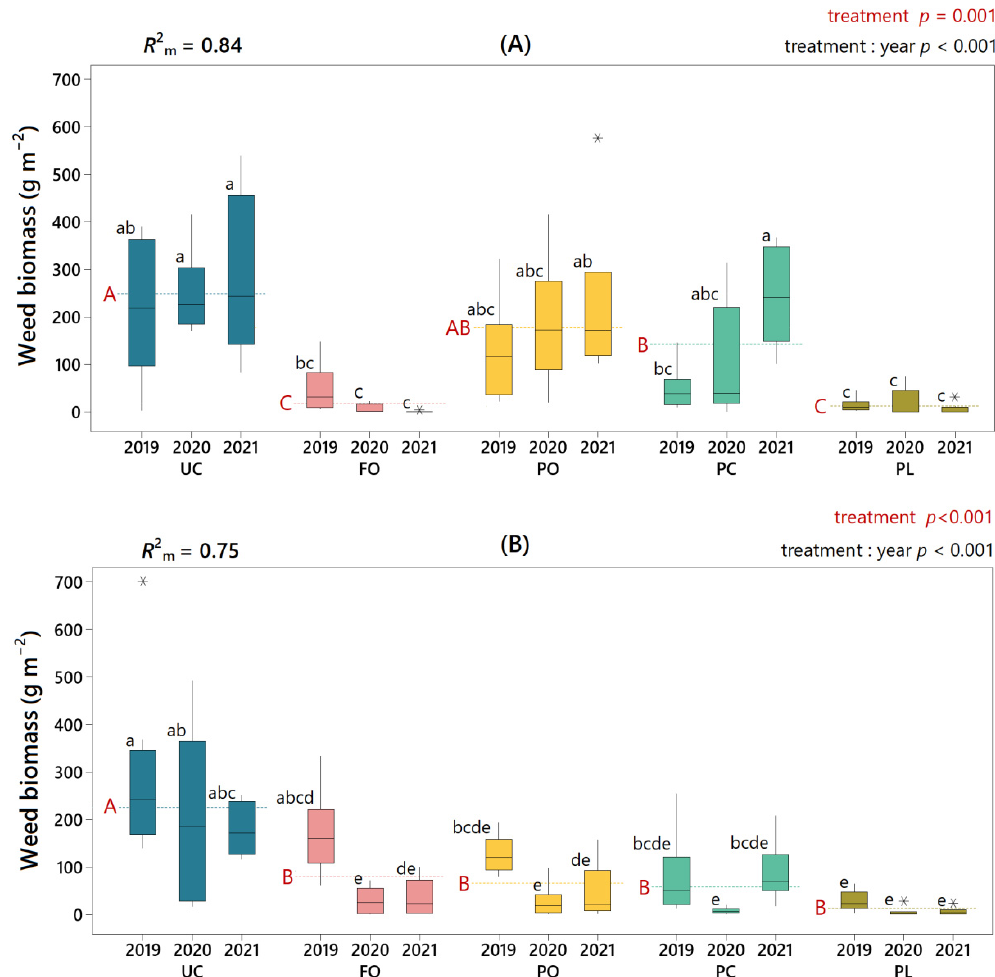
Figure 3. Weed biomass (g m − 2 ) according to treatment and year on farm A ( A ) and farm B ( B ). Dashed lines mark the three-year mean for each treatment (UC, untreated control; FO, Festuca ovina living mulch; PO, Pilosella officinarum living mulch; PC, Plantago coronopus living mulch; PL, Plantago lanceolata living mulch). Significance levels ( p -values) of the factor “treatment” and of the interaction between “treatment” and “year” are indicated in text in red and black ink, respectively. For the “treatment” level, means were significantly different if red capital letters next to the dashed lines are different. For the “treatment: year” level, boxes with different lower-case black letters had significantly different means. In the upper left corner, R 2m indicates the variance explained by the fixed effects of the mixed model. Outliers are indicated with an asterisk (*).